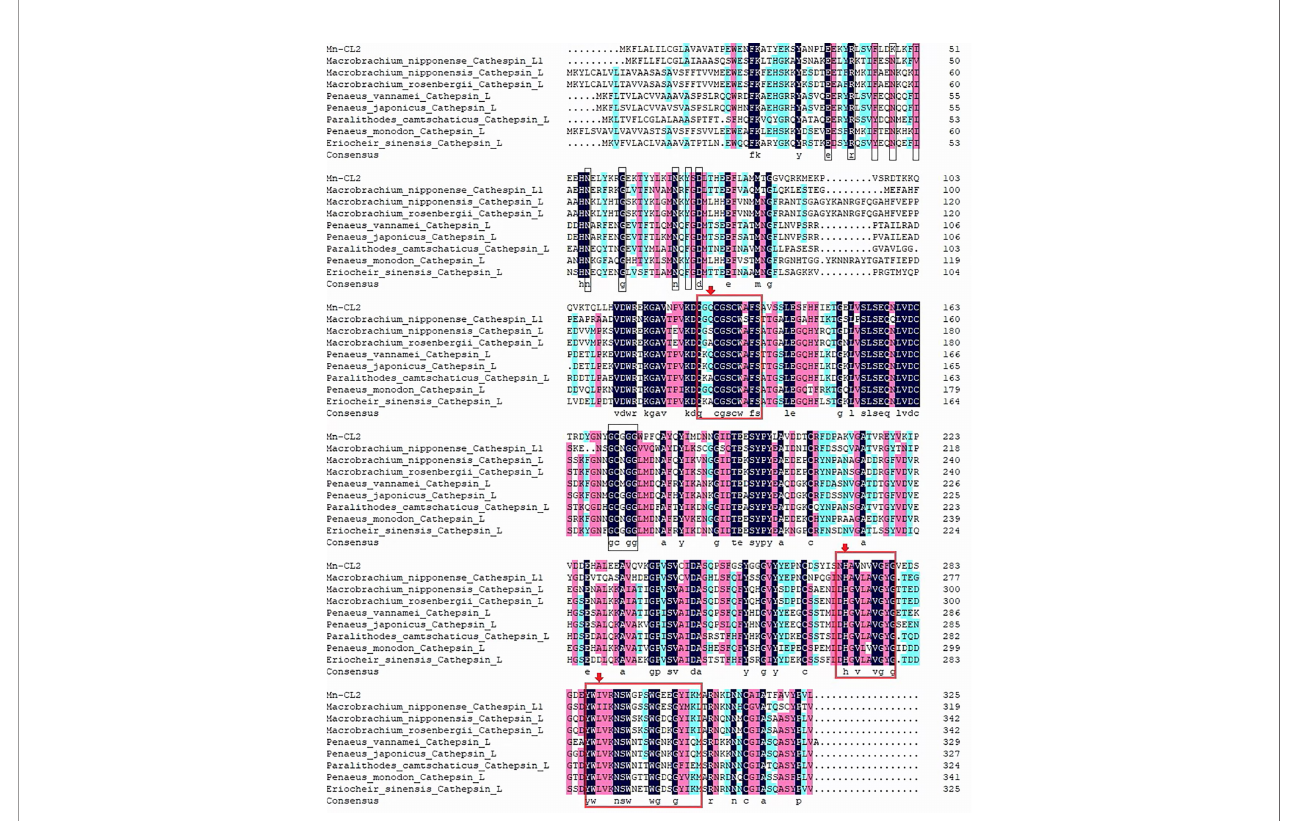
FIGURE 3 | Phylogenetic tree of Mn-CL2 amino acid sequence in different groups. The numbers below the node indicate the bootstrap value.